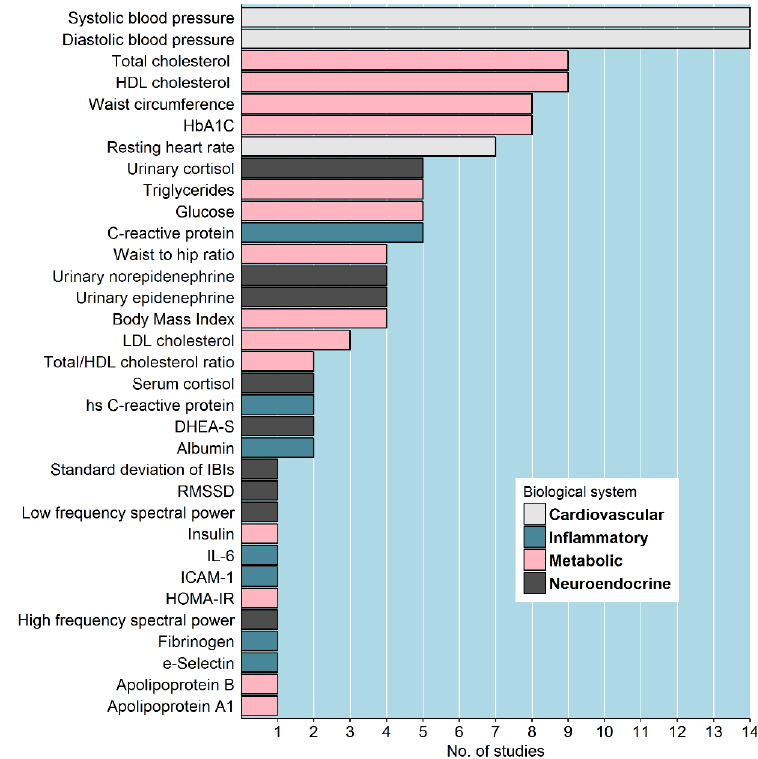
Figure 2. Biomarkers used in the included studies according to biological system. DHEA ‐ S = Dehydroepiandrosterone sulfate; HbA1C = glycosylated hemoglobin; HDL = High ‐ density lipoprotein; HOMA ‐ IR = Homeostatic model assessment insulin resistance; IBIs = Inter ‐ beat intervals; ICAM ‐ 1 = Intercellular adhesion molecule 1; IL ‐ 6 = Interleukin 6; LDL = Low ‐ density lipoprotein; RMSSD = Root Mean Square of the Successive Differences (Heart rate variability).